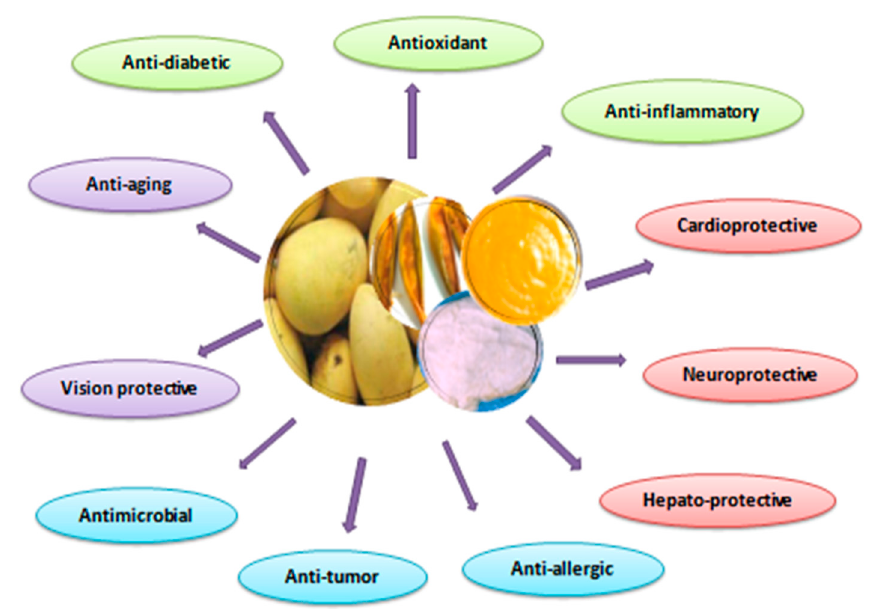
Figure 4. Potential health benefits of bioactive compounds in mango fruit.